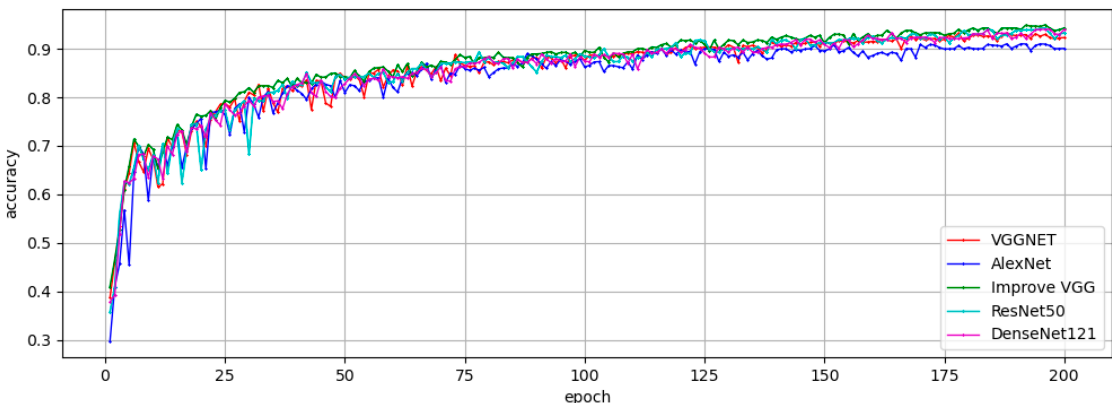
Figure 11. Training results of different models .